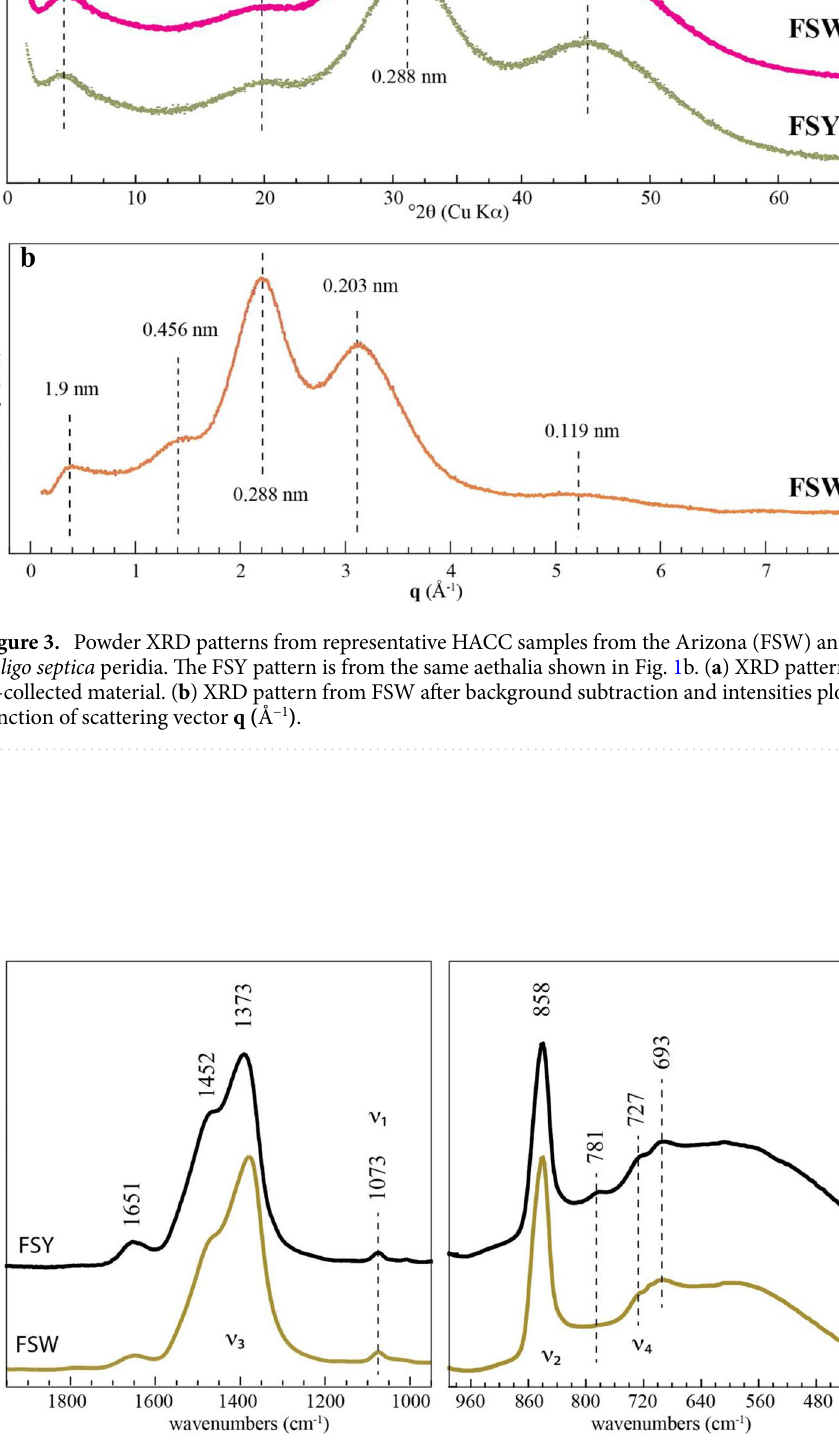
Figure 4. Selected regions of the IR spectra of FSY (sample FS1) and FSW (sample FSW4) HACC acquired at room temperature. Full spectra are shown in the supplementary information (Figs. S4,